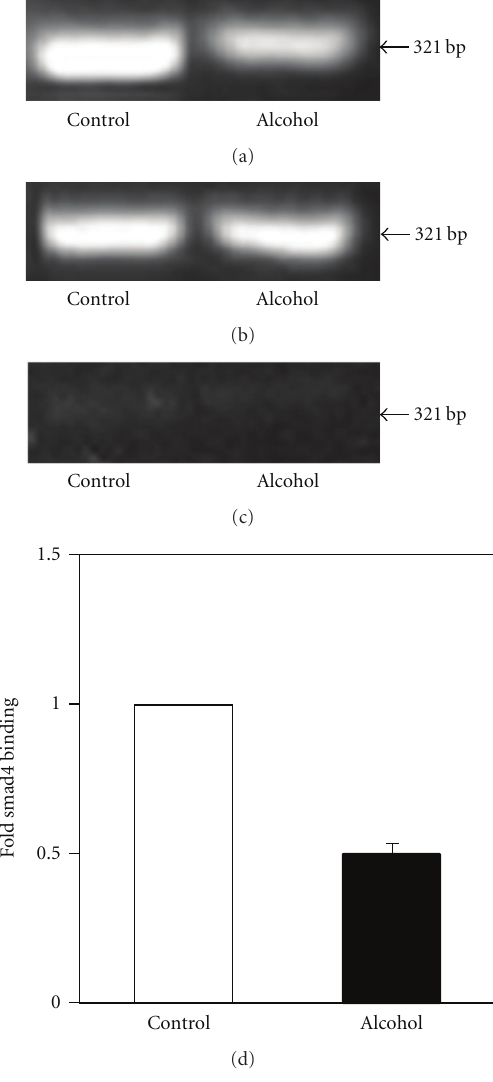
Figure 9: Smad4 Binding to Mouse Hepcidin Promoter . Chro- matin was isolated from the livers of mice fed with regular (control) or ethanol-containing (alcohol) Lieber-De Carli liquid diets. Chromatin immunoprecipitation was performed with anti- Smad4 antibody (a) or normal rabbit IgG (control) (c). The coimmunoprecipitated DNA and total input DNA (control) (b) were subjected to PCR to amplify a 321 base pair mouse hepcidin promoter region, as described in Materials and Methods. (d ) Ethidium bromide-stained agarose gels from di ff erent experiments ( n = 3) were scanned to quantify the amount of Smad4 co- immunoprecipitated DNA by normalizing to input